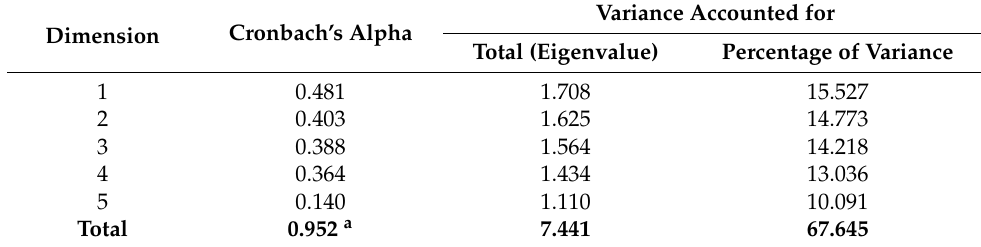
Table 6. Model summary for